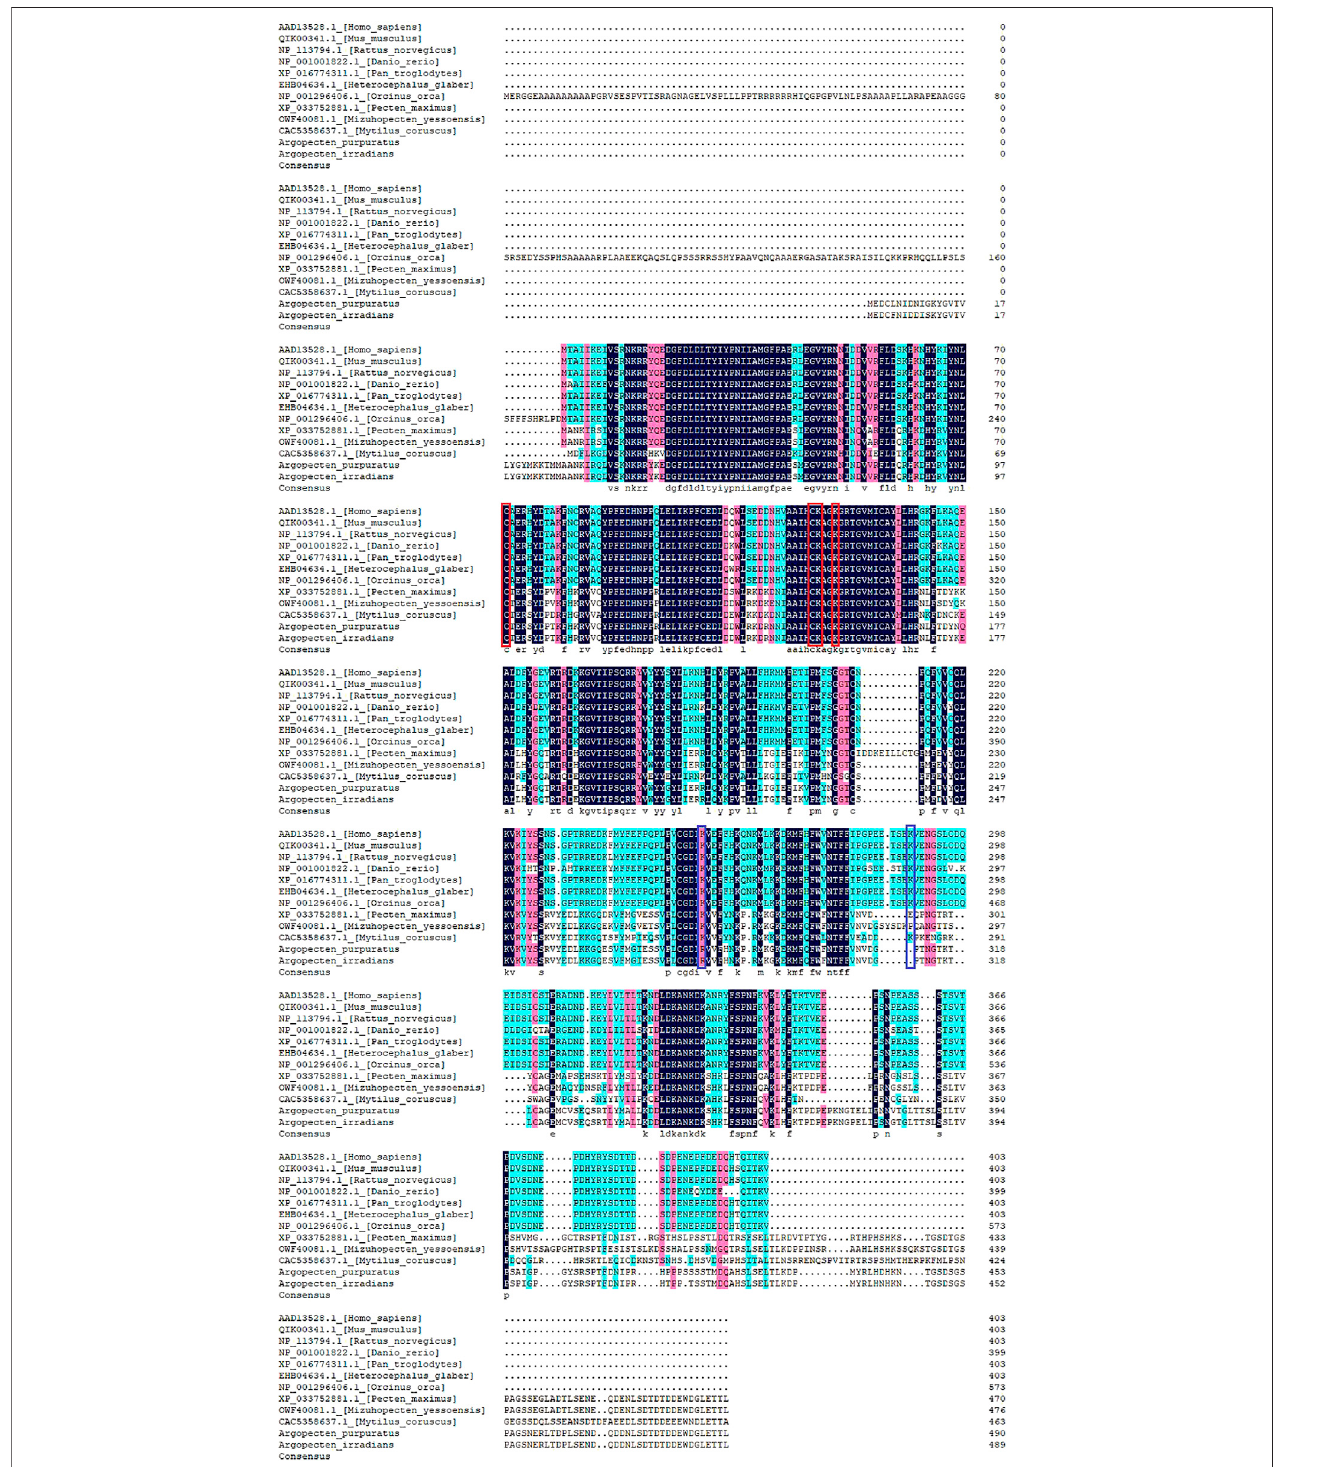
FIGURE 4 | Multiple alignment of PTEN in the 12 species. The conserved and speci fi c modi fi cation sites are represented by red and blue frame, respectively.